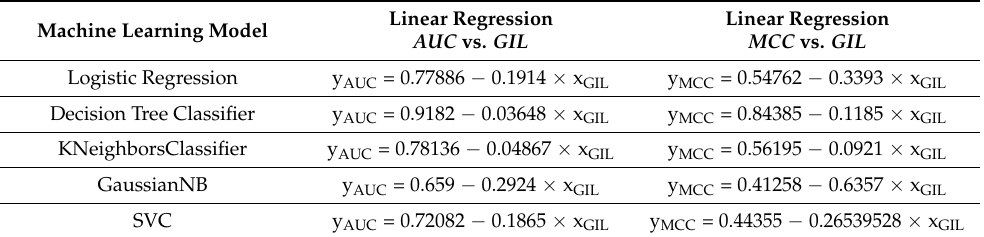
Table A3. The parameters of the linear models fitted to model the relationship between AUC and GIL, as well as MCC and GIL, for each machine learning model used in the context of this paper.